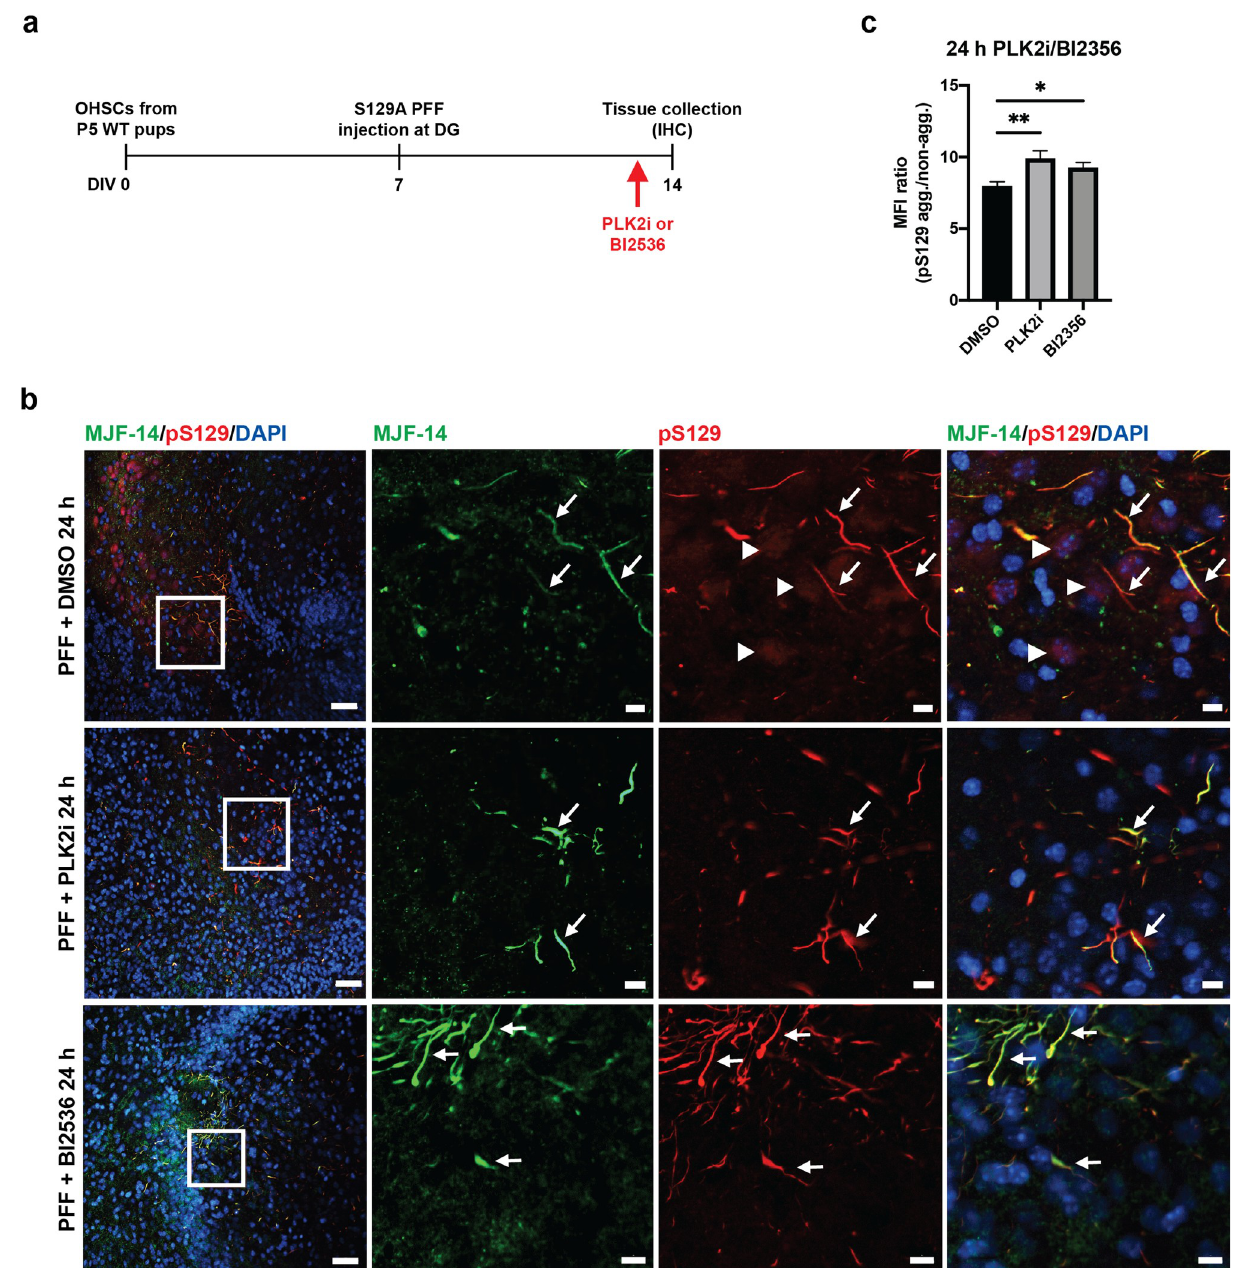
Fig 4. 24 hours treatment of OHSCs with either polo-like kinase inhibitor reduces the nuclear pS129-signal. a) Experimental setup, with addition of PLK2i or PLK1-3 inhibitor (BI2536) to the medium 24 hours prior to slice collection. b) Immunostaining with MJF-14, pS129 (11A5) and DAPI shows the reduction of nuclear pS129-staining (arrowheads) in PLK2i- and BI2536-treated slices, while aggregate-specific pS129-staining that colocalizes with MJF-14-signals remains unaffected. Scale bars = 50 μ m for the left column and 20 μ m for the magnified inserts in the three right-most columns. c) Quantification showing an increase in the ratio of mean fluorescence intensity between aggregate-specific pS129 and nuclear pS129-signal following treatment with PLK2i (p-value = 0.0039) or BI2536 (p-value = 0.0467). No difference was observed between PLK2i and BI2536 (p-value = 0.3060). Graph displays mean ± SD of 6–8 slices per group. Statistical comparisons were performed using one-way ANOVA with Fisher’s LSD test, � p < 0.05, �� p < 0.01. Images are representative of three independent experiments.